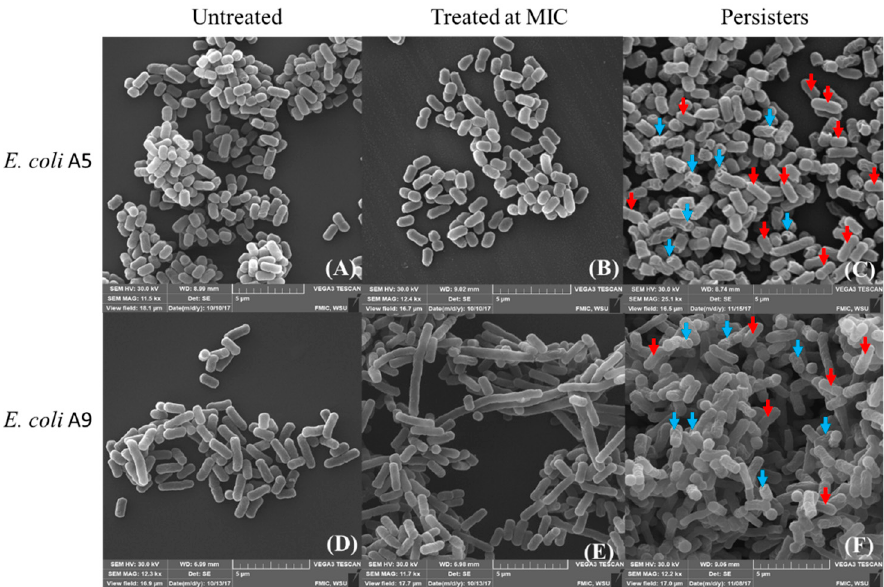
4 of 23 Figure 2. Representative AFM height images showing morphological differences among: ( A, D ) natural MDR cells of Strains A5 and A9, respectively; ( B, E ) cells treated with ampicillin at various MICs for Strains A5 and A9, respectively; and ( C, F ) persister cells of Strains A5 and A9, respectively. Red arrowheads indicate dividing cells in the persister cells’ subpopulations (image C ), blue arrowheads depict dividing cells in the absence of ampicillin (images A and D ), and green arrowheads show elongated cells after exposure to MIC (image E ). To investigate what happens to the cells’ ultrastructures, we turned our attention to high- resolution images acquired with SEM (Figure 3). The SEM images clearly depicted the expected elongation of Strain A9 cells as a result of exposure to ampicillin at MIC (Figure 3F). The results of SEM imaging are consistent with those of AFM height images (Figure 2). The SEM images depicted